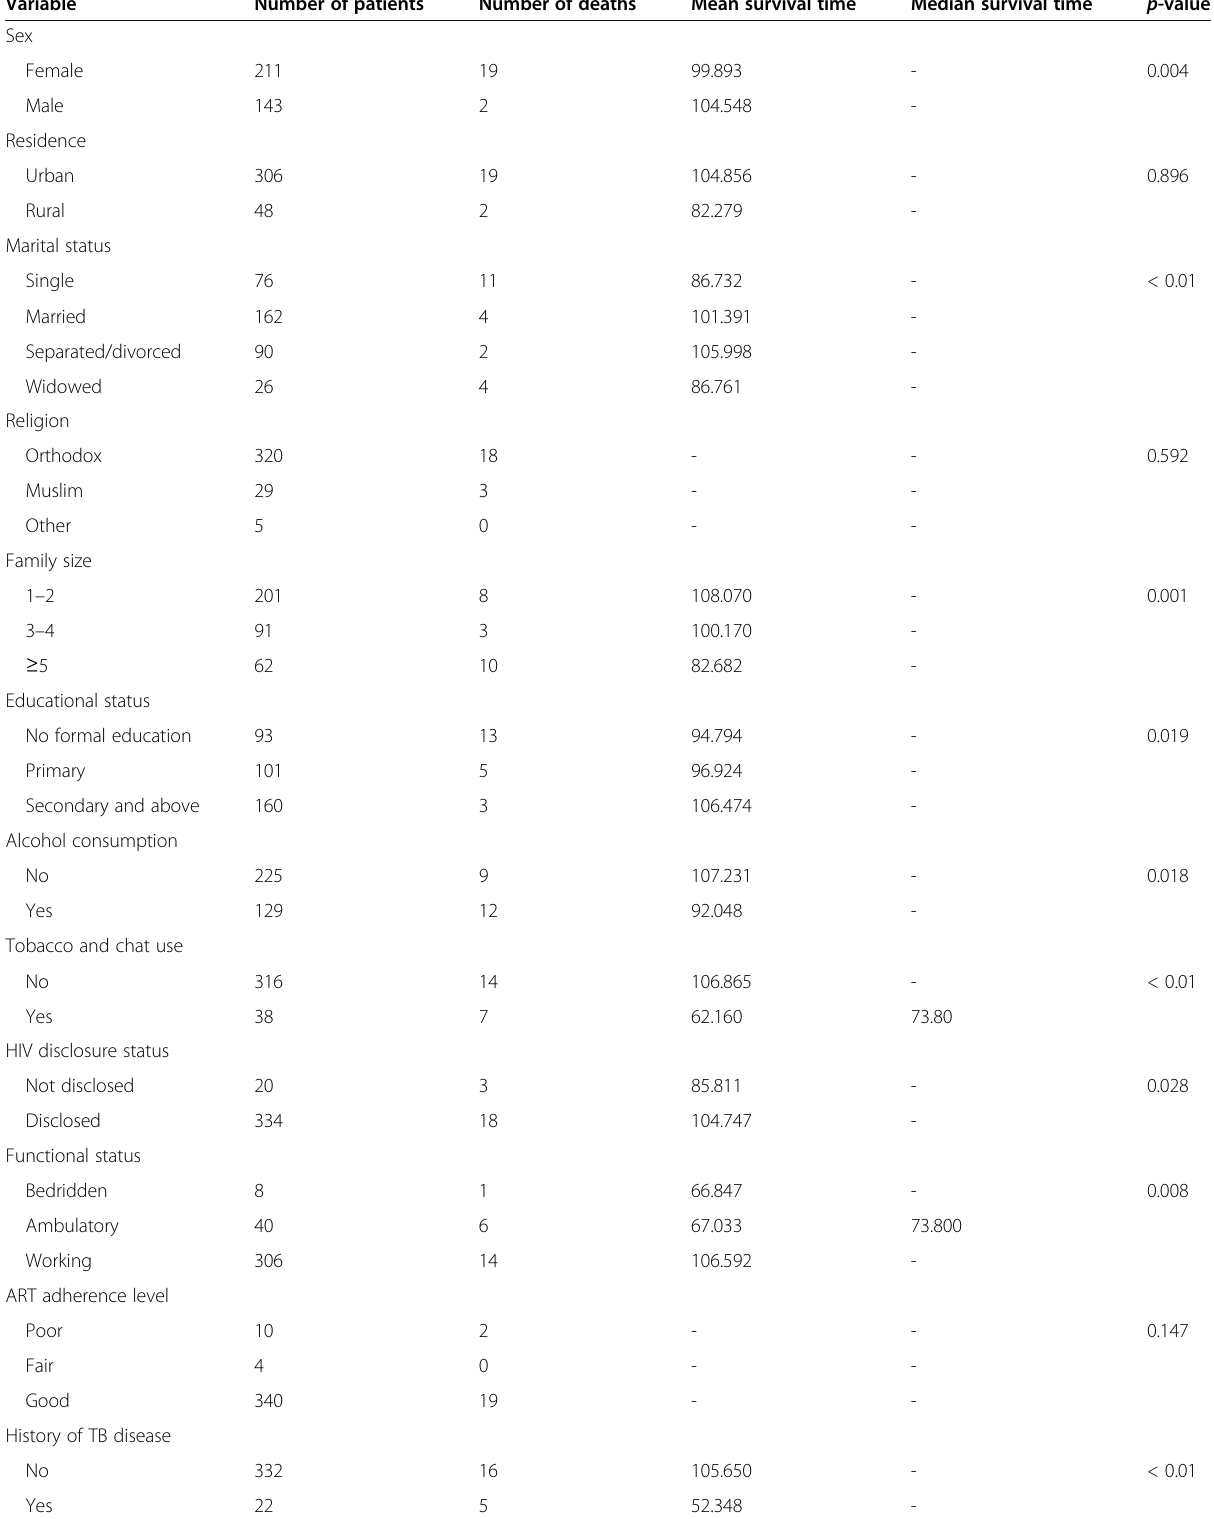
Table 4 Survival time by potential demographic, clinical, and risk variable for HIV/AIDS patients treated under ART (University of Gondar teaching hospital, 2009 –